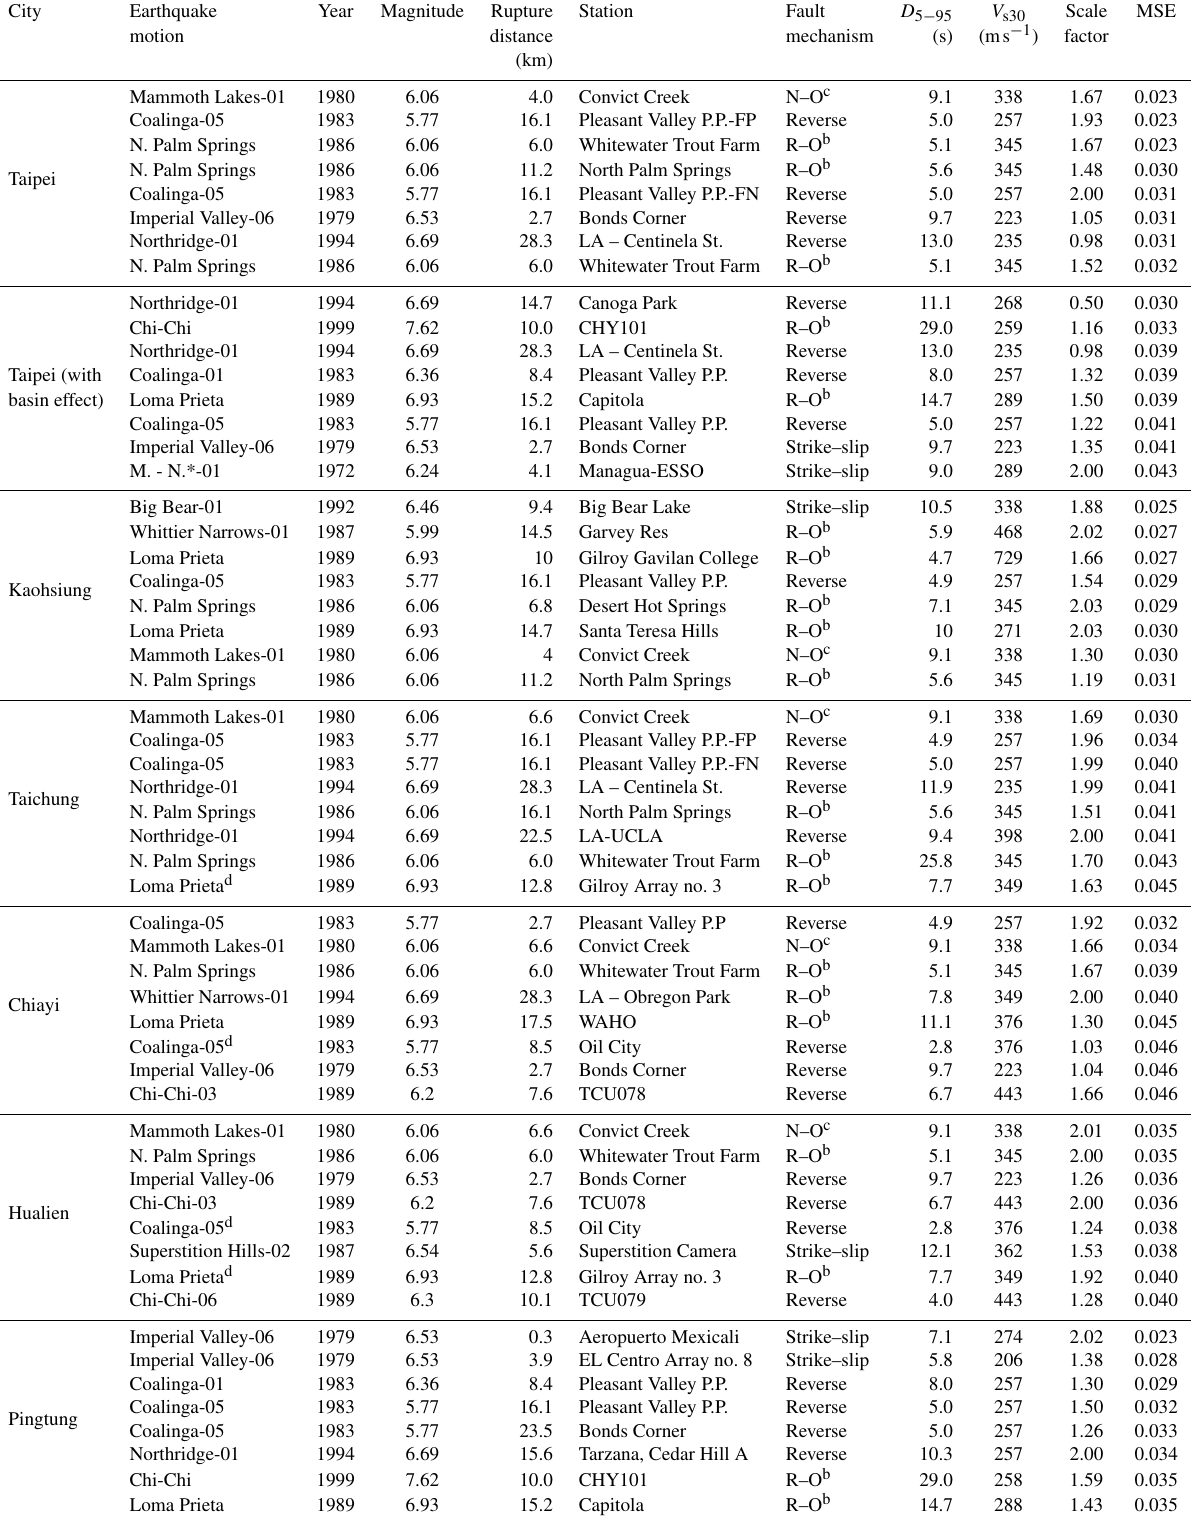
Table 4. Summary of the earthquake time history recommendations from the NGA database with DSHA calculations. City Earthquake Year Magnitude Rupture Station motion distance mechanism